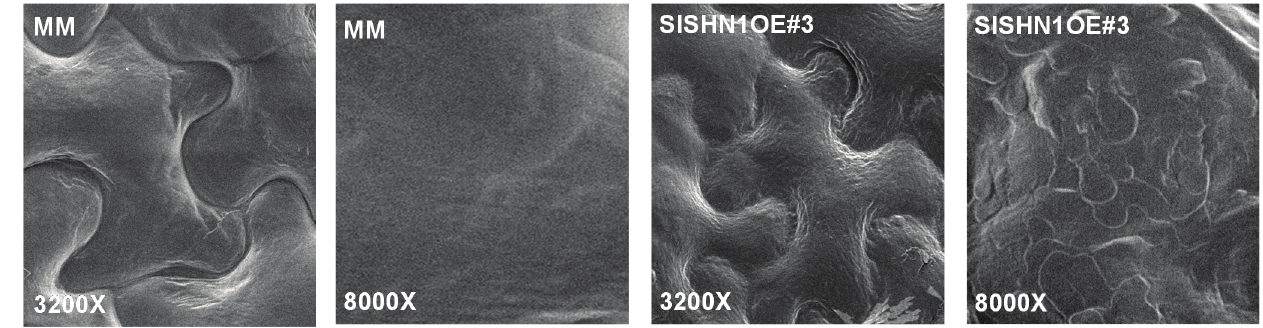
Figure 4. Scanning electron microscopy photos showing the leaf abaxial side in wild type (MM) and transgenic line over-expressing SlSHN1 (SLSHN1OE#3) at two magnification powers (3200× and